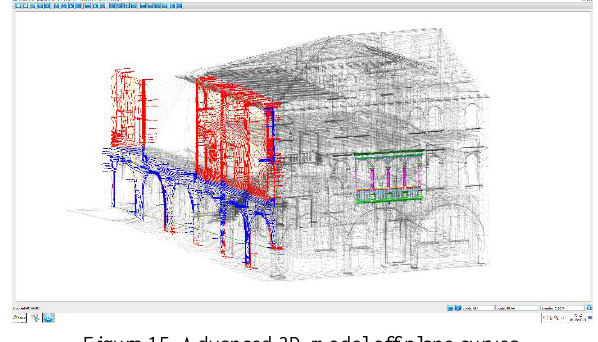
Figure 15. Advanced 3D model off plane curves.